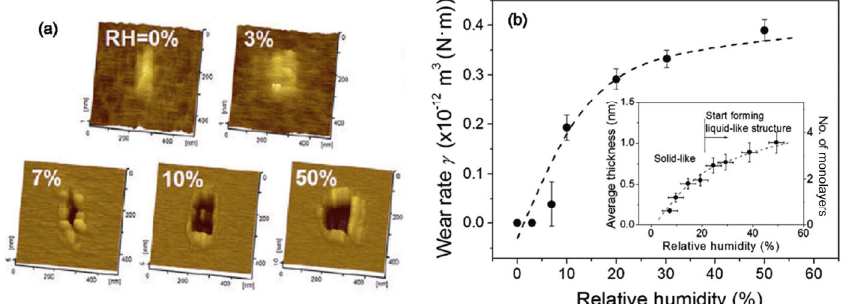
Fig. 14 Tribochemical wear of oxide-covered Si sliding against SiO 2 tip at various RH values. (a) AFM images of wear scars on silicon surface at representative RH values; applied load, sliding speed, and sliding cycle were 3 μ N, 2 μ m/s, and 200, respectively. (b) Wear rate is a function of RH; inset shows adsorption isotherm of native oxide-covered Si (100) surface in humid air. Reproduced with permission from Ref. [142], © American Chemical Society